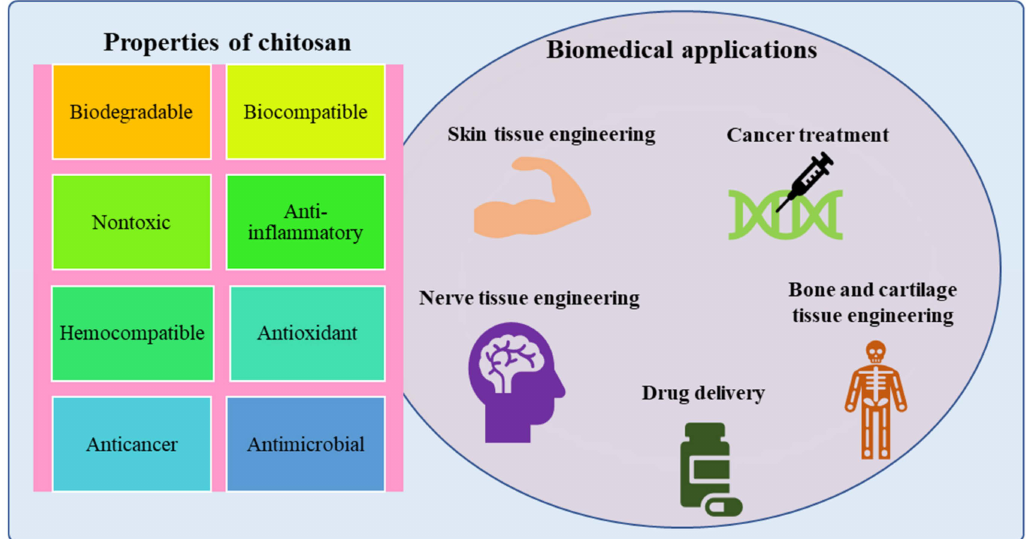
Figure 1. Properties of chitosan-based nanoparticles and their biomedical